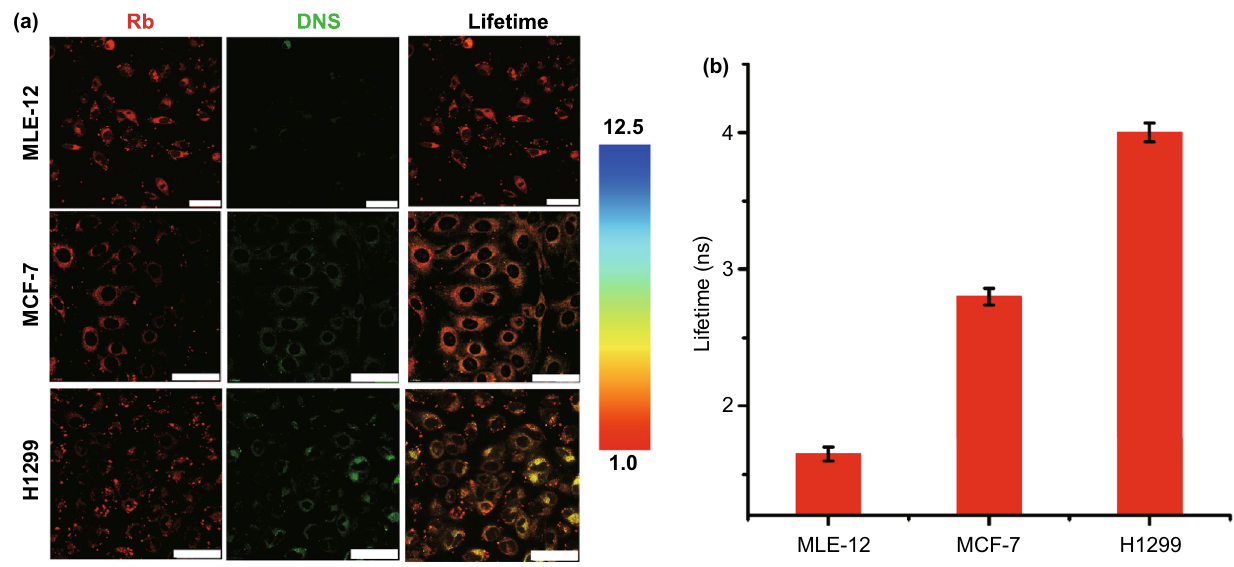
Fig. 5 a Confocal images and fluorescence lifetime images for MLE-12, MCF-7, and H1299 cells with sPPDN. Scale bar: 50 µm. b Summa- rized data of lifetime in different cell lines toward sPPDN treatment. Error bars are mean ± SD (n = 3 independent